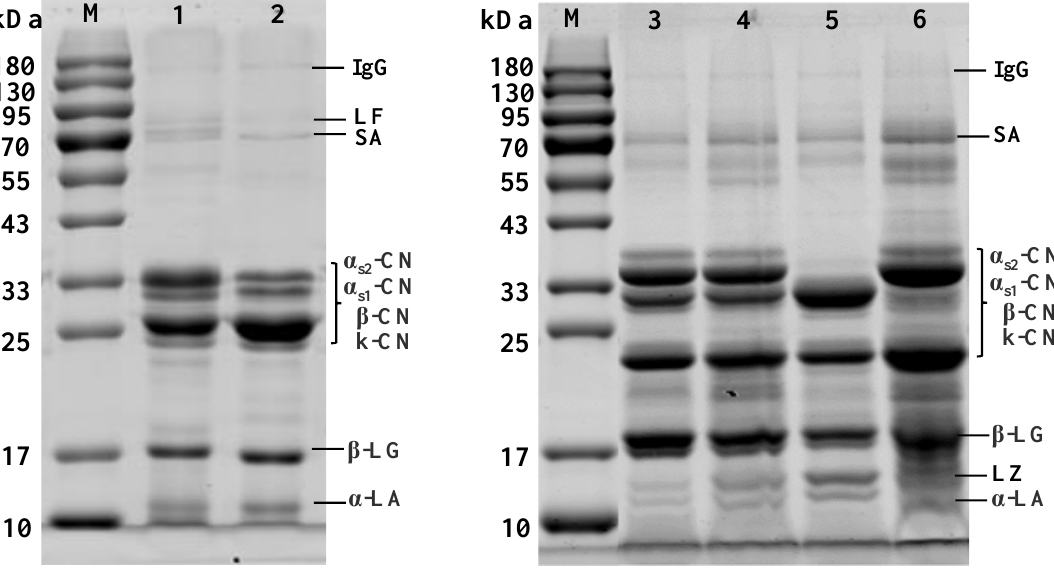
Values within each row with different superscripts were significantly different ( p < 0.05). Data are presented as the mean ± standard deviation, n = 3.